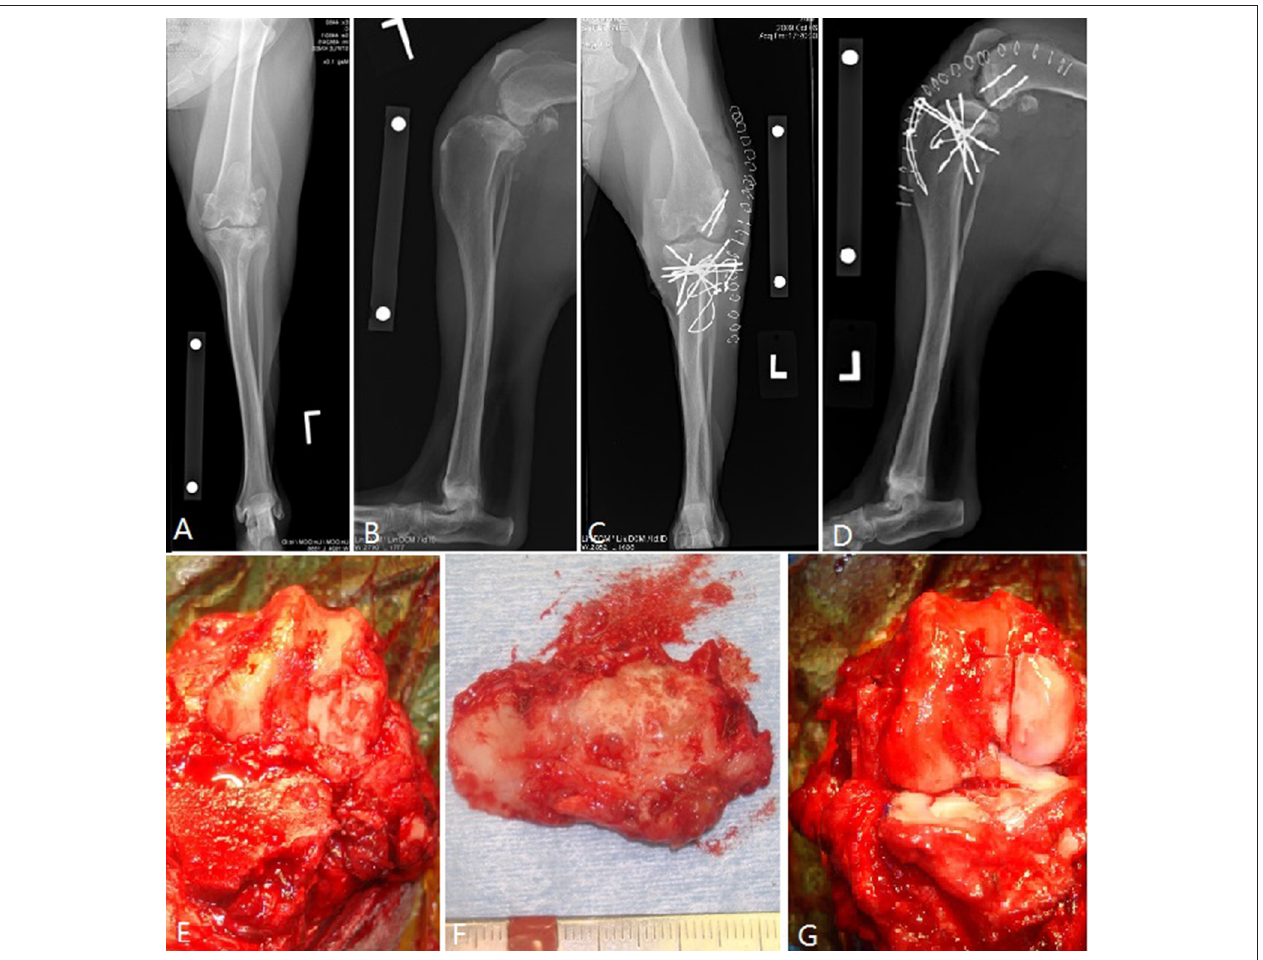
FIGURE 3 | Osteochondral allograft resurfacing of the canine tibial plateau and lateral femoral condyle with transplantation of fresh meniscal allografts in a dog with numerous previous surgeries for cranial cruciate ligament and meniscal deficiency. (A,B) Pre-operative radiographs; (C,D) post-operative radiographs. Note a decrease in tibial plateau angle performed to address the cranial cruciate ligament deficiency. (E–G) Intra-operative images showing removal of the diseased tibial plateau and what remained of the menisci and the post-transplantation images showing the OCA tibial plateau and lateral femoral condyle in situ along with the two allograft menisci. This dog had seroma formation and had implant migration which required implant removal after integration of the grafts. The dog achieved a full functional